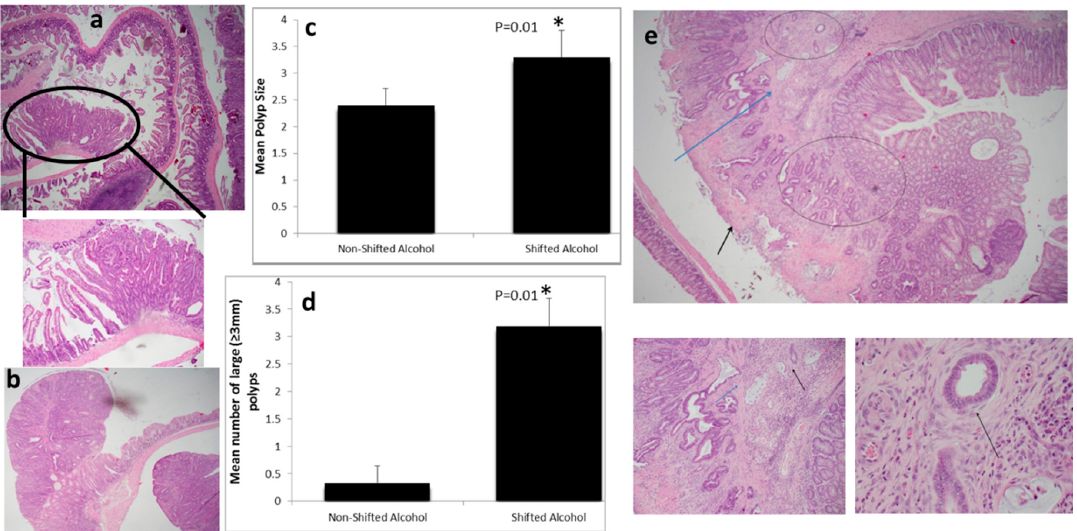
Figure 1. Light:dark (LD) shift accelerates intestinal tumorigenesis in alcohol treated mice: ( a ) Tubular adenoma in the ileum (4×). The circle is a 10× view of the same lesion, showing clear delineation between adenoma ( right ) and adjacent normal mucosa ( left ); ( b ) Colonic tubular adenoma (4×); ( c ) Polyp size (* p = 0.01) and ( d ) number of large polyps (* p = 0.01) were increased significantly by light:dark shifting; ( e ) Only mice in the experimental group developed invasive colon cancer; picture shows invasive adenocarcinoma emerging from a tubular adenoma. Two glands immediately above muscularis mucosa (MM) (MM is indicated by the blue arrow) are infiltrating the mucosa, and a few glands in top center have infiltrated the submucosa (top circle). Area of invasion to MM and submucosa is also observed in the center-bottom (blue circle). Part of the polyp surface was eroded—an inconsequential finding (black arrow). Right-bottom panel is a larger view (10×) of the same polyp, showing glands infiltrating into the MM (blue arrow) and beyond (black arrow). The left-bottom panel is the high power view (40×) of two glands that have infiltrated into the submucosa. At this power, desmoplasia is apparent as a subtle rim around the glands (black arrow); desmoplasia is an unequivocal feature of invasive carcinomas. Note: 4×, 10×, and 40× fields are 25.0 microns, 10.0 microns, and 2.5 microns in diameter, respectively.